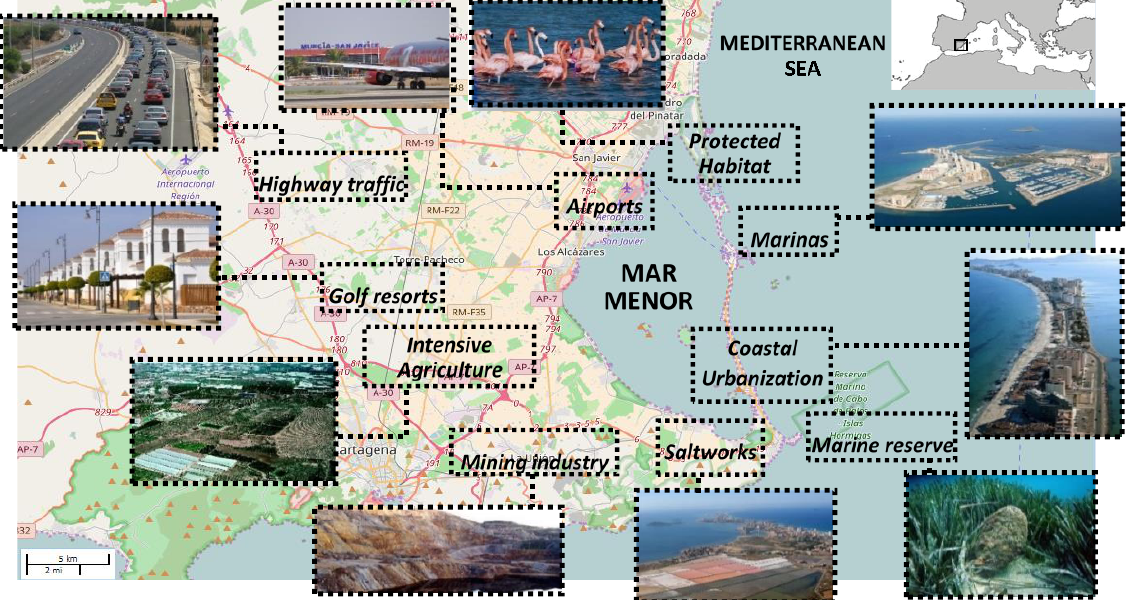
Figure 3. Area of study: Campo de Cartagena watershed surrounding the Mar Menor coastal lagoon. Freshwater that inputs into the lagoon were traditionally restricted to six main ephemeral watercourses called wadis. These wadis can reach lengths of over 50 km.